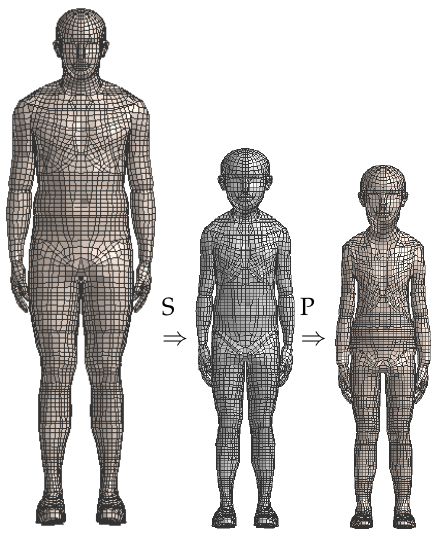
Figure 8. Personalization process. Reference model ( left ), scaled model ( middle ), and personalized model ( right